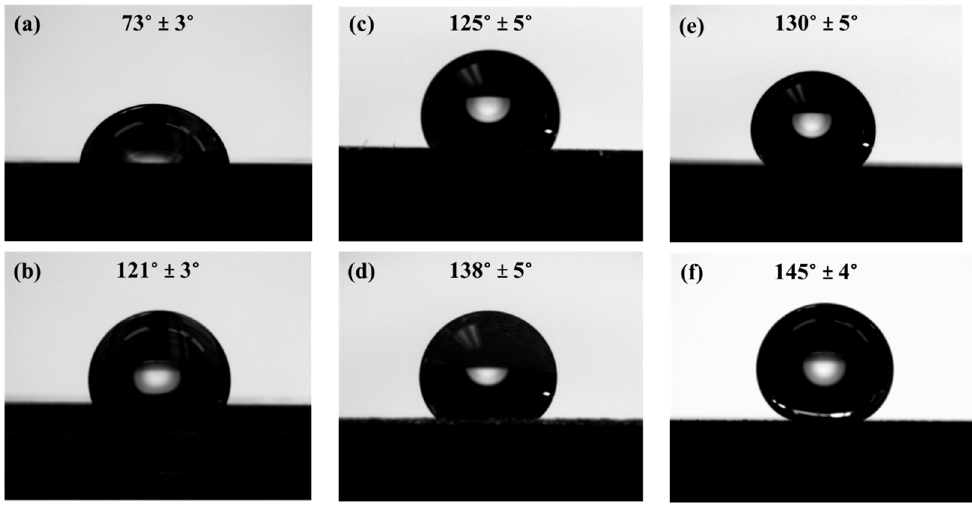
Figure 5. Contact angle measurements of the ( a ) base without coating; ( b ) coated base; ( c ) channeled without coating; ( d ) coated channeled; ( e ) varied channeled without coating; and ( f ) coated varied channeled surfaces.